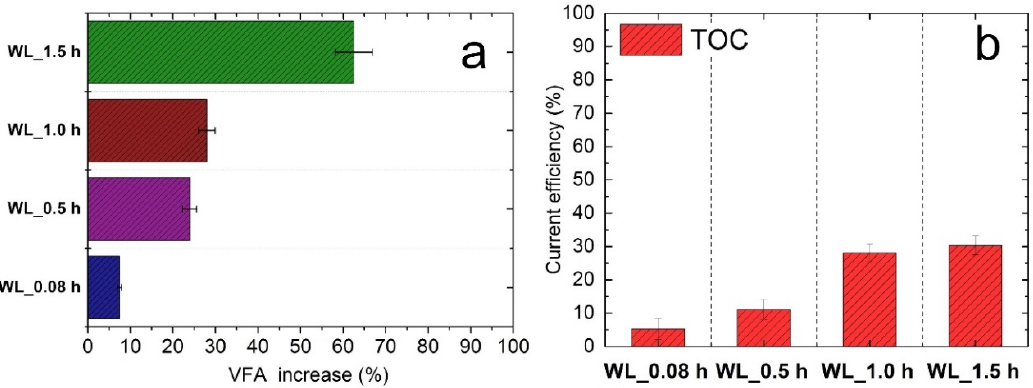
Figure 3. Effects of electro-oxidation pre-treatment on: ( a ) volatile fatty acids (VFAs) and ( b ) current efficiency calculated using the decrease in total organic carbon (TOC) values as a